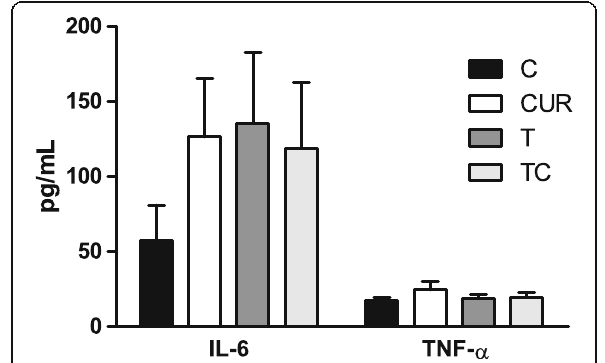
Fig. 3 Cytokine levels after the 20-week experimental protocol from control ( C ), curcumin ( CUR ), trained ( T ), trained plus curcumin ( TC ) NOD